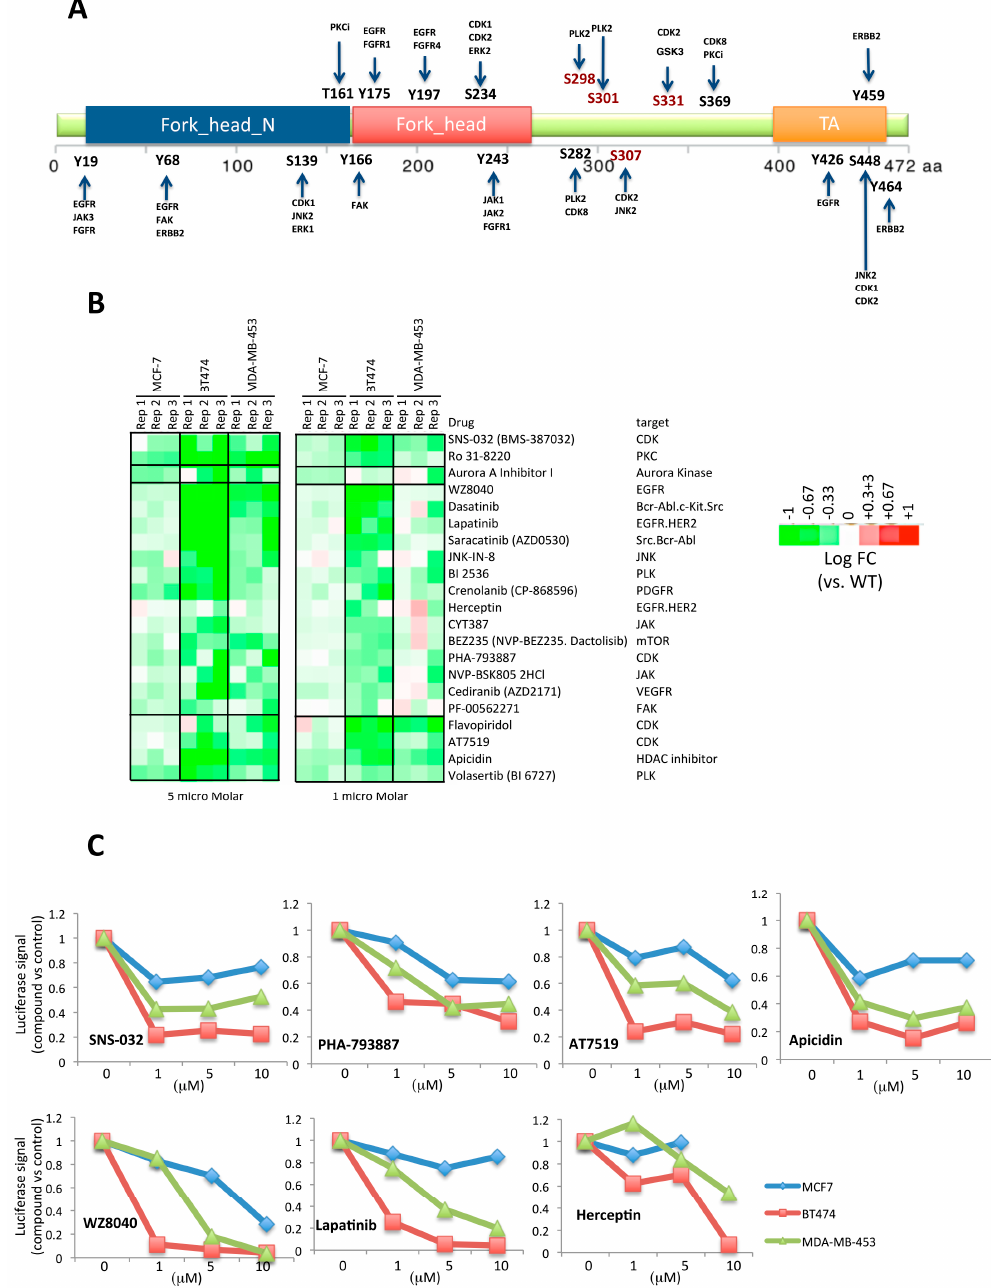
Figure 3. Validation of chemicals by the second screening. ( A ) Diagram showing potential FOXA1 phosphorylation sites and corresponding kinases. The prediction of FOXA1 phosphorylation sites was performed with GPS 3.0, and corresponding kinases that overlapped with positive targets in the first chemical screening were identified. Both overlapping kinases and their potential sites are labeled. ( B ) Heatmap showing the result of compounds with a significant change in luciferase expression. 45 chemicals were used for the second chemical screening for three cell lines and two concentrations (5 and 1 microM). The heatmap illustrates the log2 fold change in luciferase expression (drug treatment vs. control) of cells treated with the 21 compounds with a significant p value. ( C ) Dose responses of compounds with a significant inhibitory effect in the expression of luciferase. The plots represent the relative signal of the compounds targeting the receptor tyrosine kinases HER2/EGFR and the cyclin-dependent kinases (CDK) vs. control treated cells. The average of three independent experiments for different concentrations tested (0, 1, 5, and 10 micro Molar) is plotted.